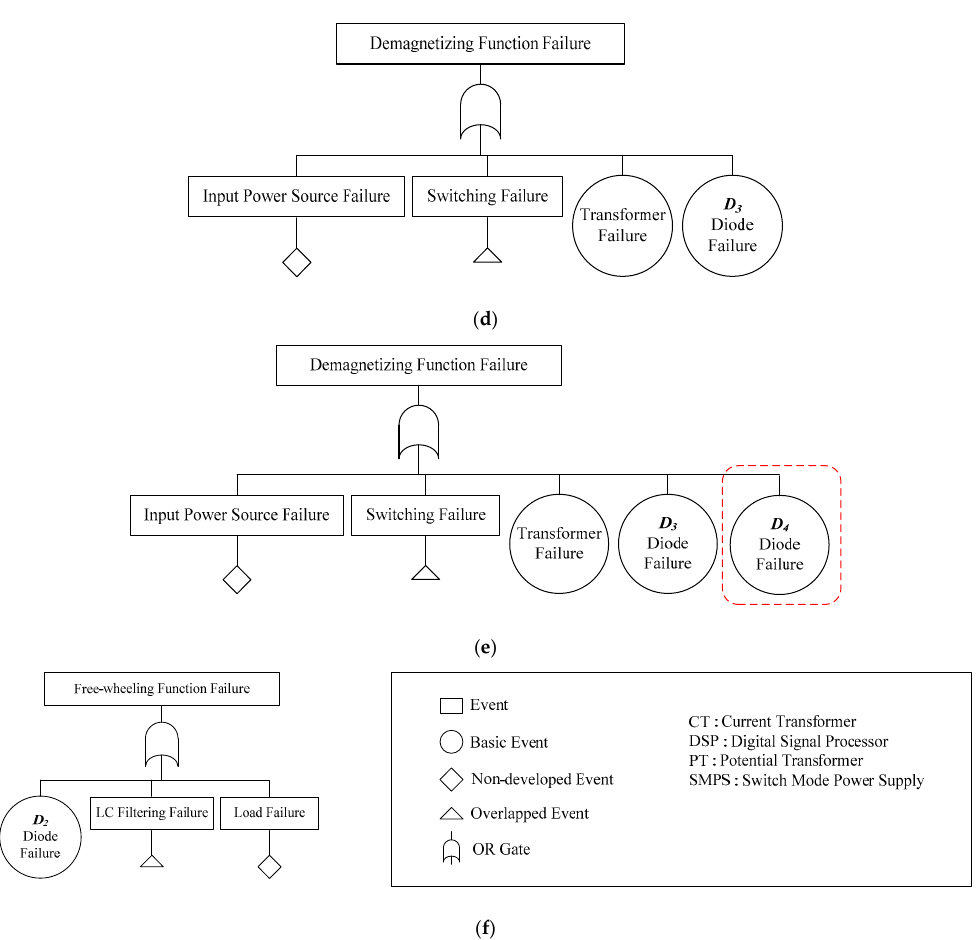
Figure 4. Fault tree of the single-ended and double-ended forward converter: ( a ) main fault tree; ( b ) sub-fault-tree for power transferring function of single-ended; ( c ) sub-fault-tree for power transferring function of double-ended; ( d ) sub-fault-tree for the demagnetizing function of single-ended; ( e ) sub-fault-tree for the demagnetizing function of double-ended; ( f ) sub-fault-tree for freewheeling function.